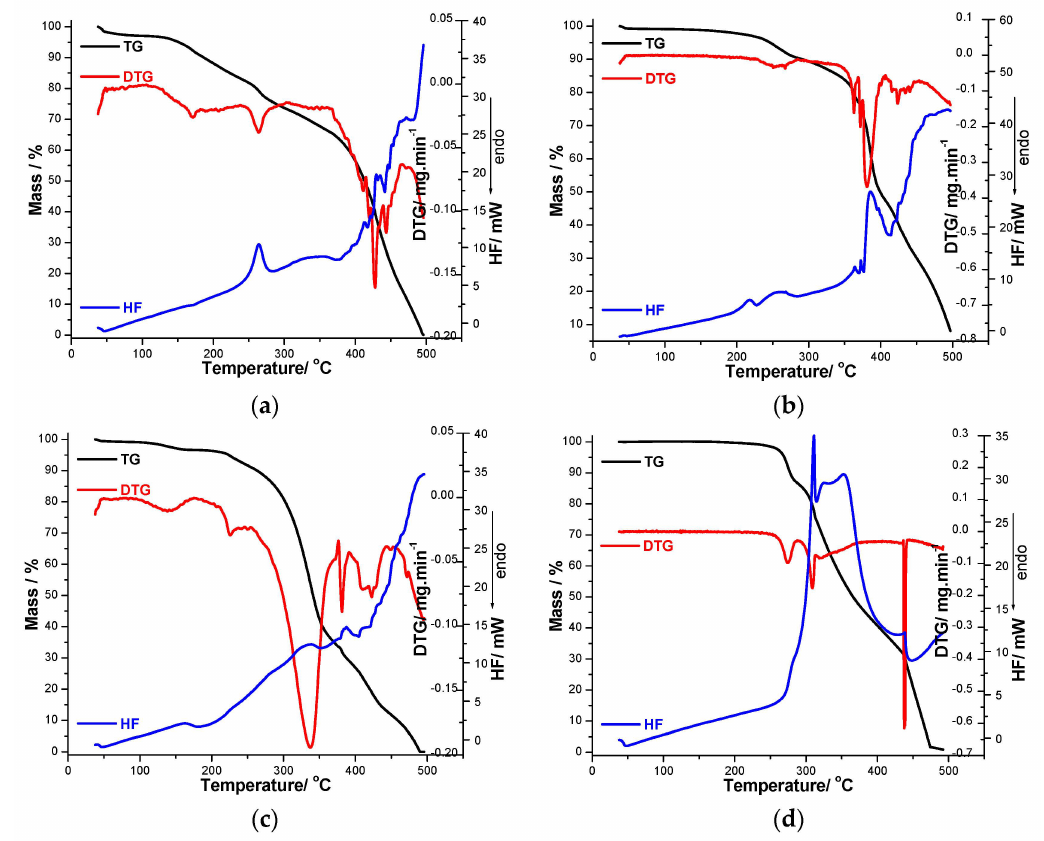
Figure 3. Thermoanalytical TG/DTG/HF data recorded in air atmosphere up to 500 ˝ C for compounds ( a ) C1 ; ( b ) C2 ; ( c ) C3 and ( d ) C4